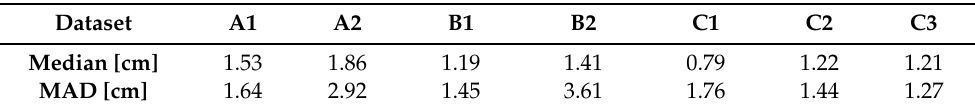
Table 4. Median distance error [cm] and median absolute deviation (MAD) [cm] between structural points and reconstructed